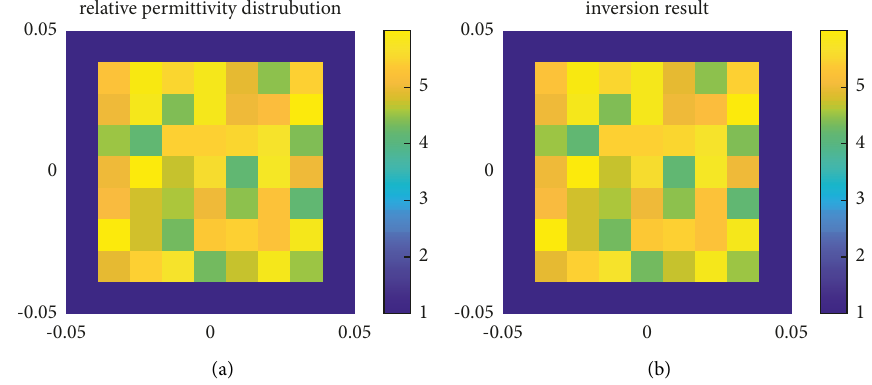
Figure 7: Comparison results of the relative permittivity distribution of the scatterer with random relative permittivity.